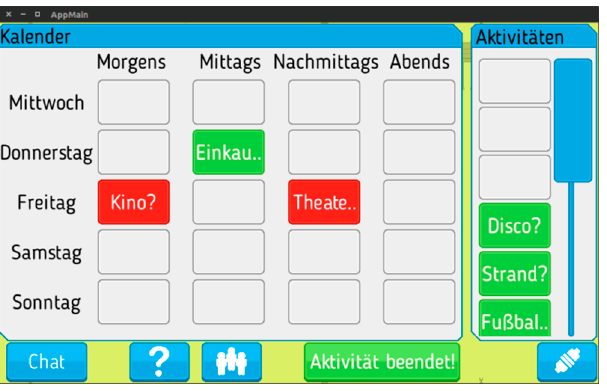
Figure 7. Example of a student’s personal agenda and the appointments stored (digital version).